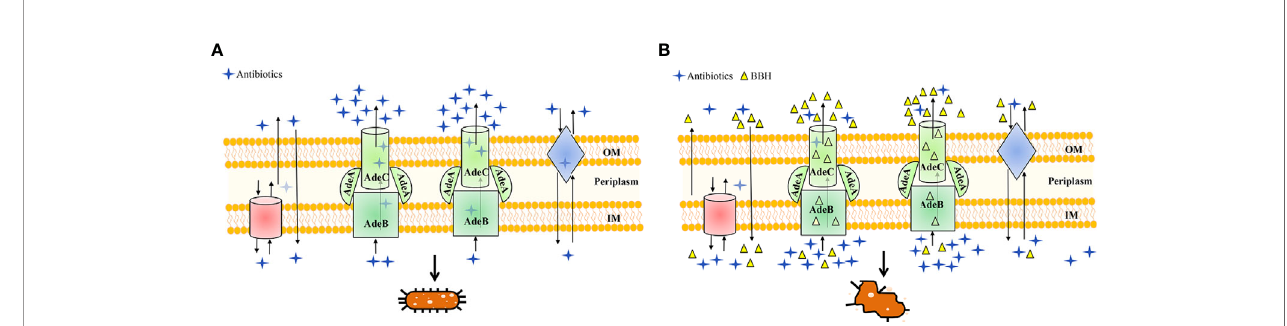
FIGURE 6 | Schematic diagram highlighting the antibiotic ef fl ux mechanisms with (A) BBH absent or (B) present. MDR A. baumannii may harbor abundant pump systems. For instance, AdeABC pump contributes to resistance by extruding a wide range of antibiotics into the extracellular environment, which causes a lower dose of antibiotics to accumulate within bacteria and leads to multidrug resistance and concomitant cell growth, as illustrated in (A) . However, in the presence of BBH (B) , multidrug resistance of antibiotics can be reversed for it could occupy the binding sites of AdeABC and other ef fl ux proteins as a positive pump competitor. This way both the penetration of antibiotics from the outer membrane (OM) and accumulation inside the inner membrane (IM) are maintained, leading to the killing